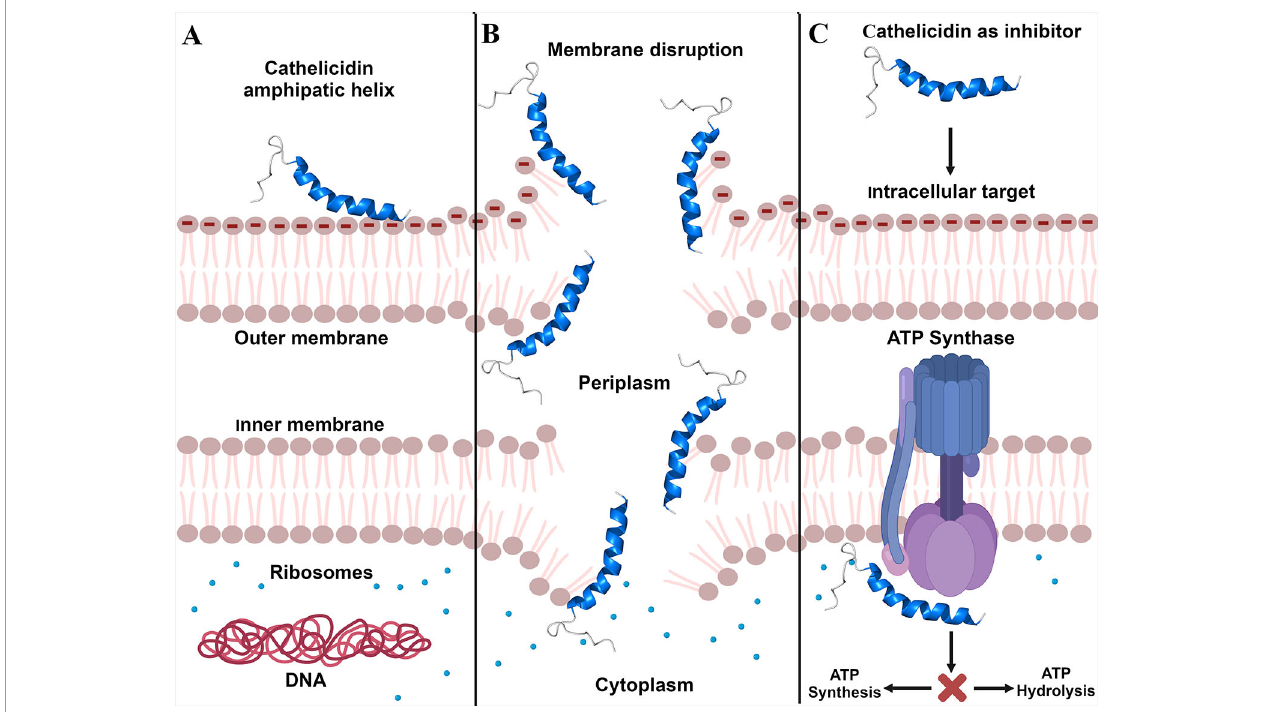
FIGURE 1 | Cathelicidins' mechanisms of action. (A) , Cathelicidin structural modi fi cation by electrostatic interaction with Gram-negative bacterial membrane. (B) , Bacterial membrane disruption caused by cathelicidins. (C) , Inhibition of ATP synthesis/hydrolysis caused through cathelicidins binding to ATP synthase. Created with